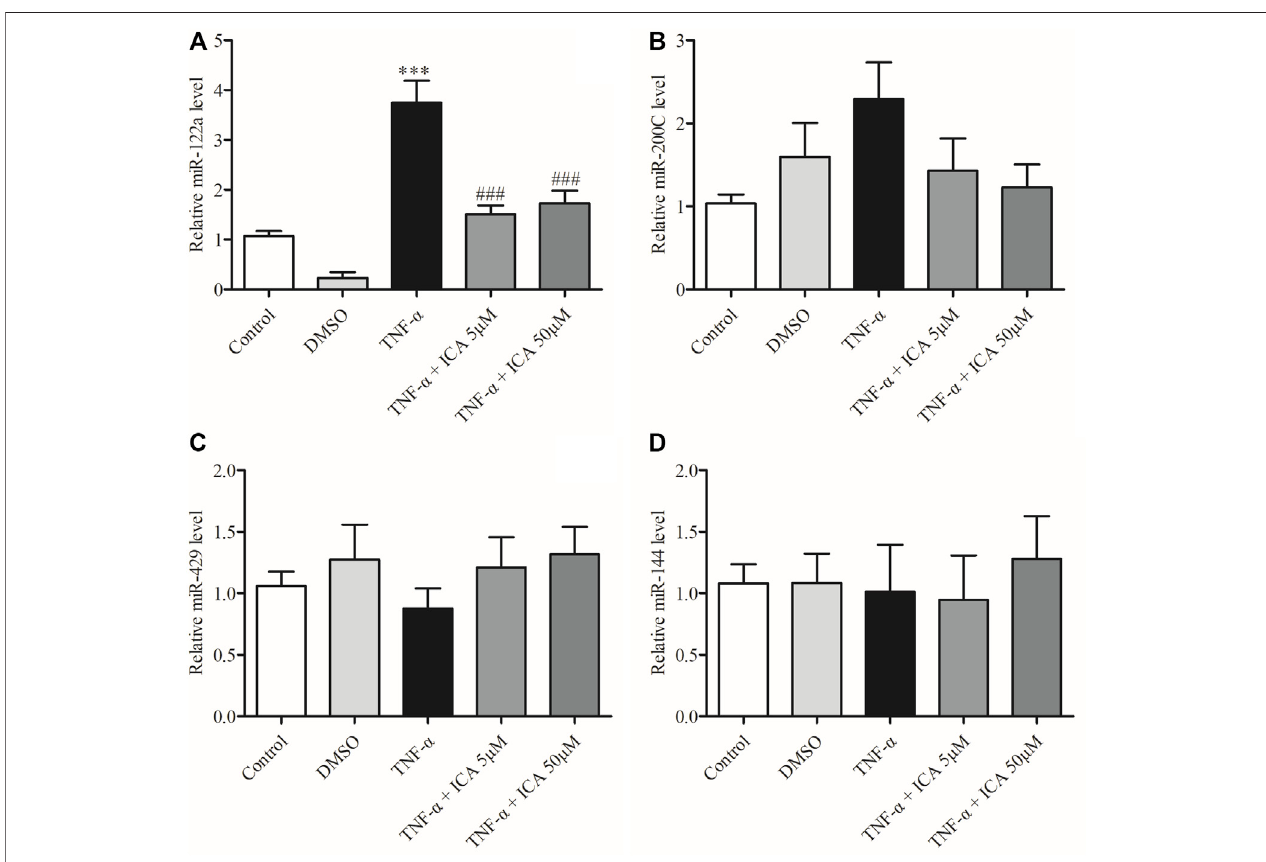
FIGURE 7 | ICA reversed the upregulation of miR-122a in Caco-2 cells induced by TNF- α . Detected the expression levels of (A) miR-122a, (B) miR-200C, (C) miR- 429, and (D) miR-144. *** p < 0.001 vs. Control group. ### p < 0.001 vs. TNF- α group, n = 5 – 12.